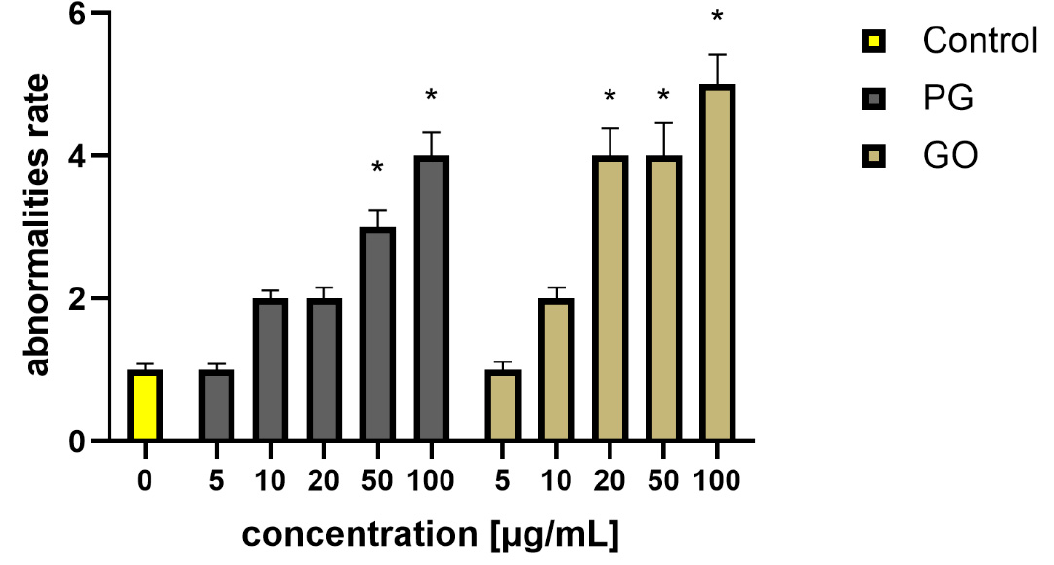
Figure 3. Percentage of abnormalities observed in the 96 h of the development of zebrafish embryos in the experimental groups. Values in the rows marked with an asterisk show statistically significant differences ( p < 0.05) as compared to the control assay. Abbreviations: C—control group (untreated cells); PG—pristine graphene; GO—graphene oxide.